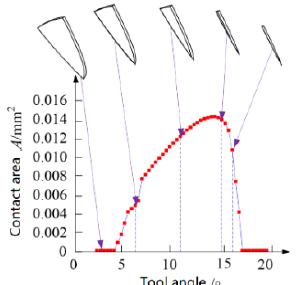
Figure 15. Cutting edge contact area in different tools angles.